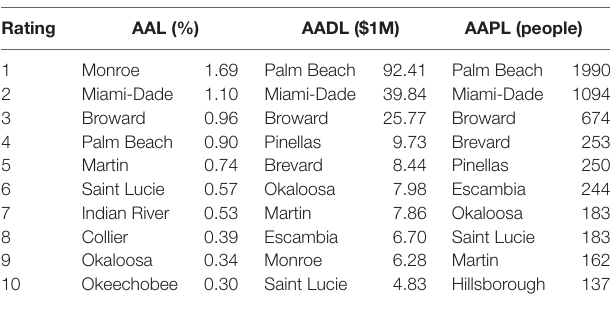
TaBle 4 | Counties with the highest mitigation potential.